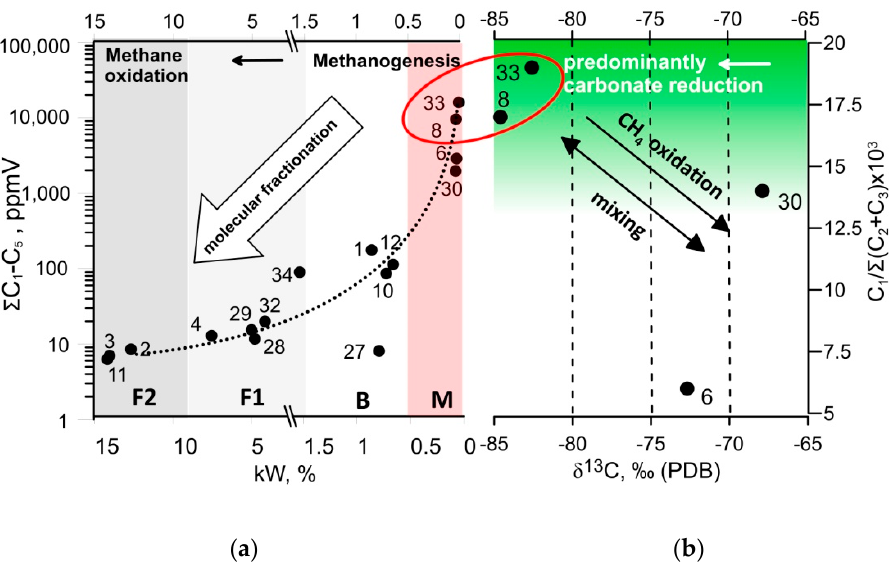
Figure 7. ( a ) Headspace diagram of C 1 -C 5 HG (modified after [30]), the letters below indicate the grouping of the ground ice samples in terms of methane cycling based on molecular composition of the hydrocarbon gases (HCG): M—methane enriched; B—background; F1 and F2—fractionated (methane depleted); ( b ) Bernard diagram of the molecular ratio of C 1 /C 2 +C 3 against δ 13 C CH 4 (modified after [39]). Red ellipse indicates the TGI samples with similar molecular of C 1 -C 5 HG composition of and δ 13 C CH 4 v values Geosciences 2020 , 10 , x FOR PEER REVIEW 14 of 21